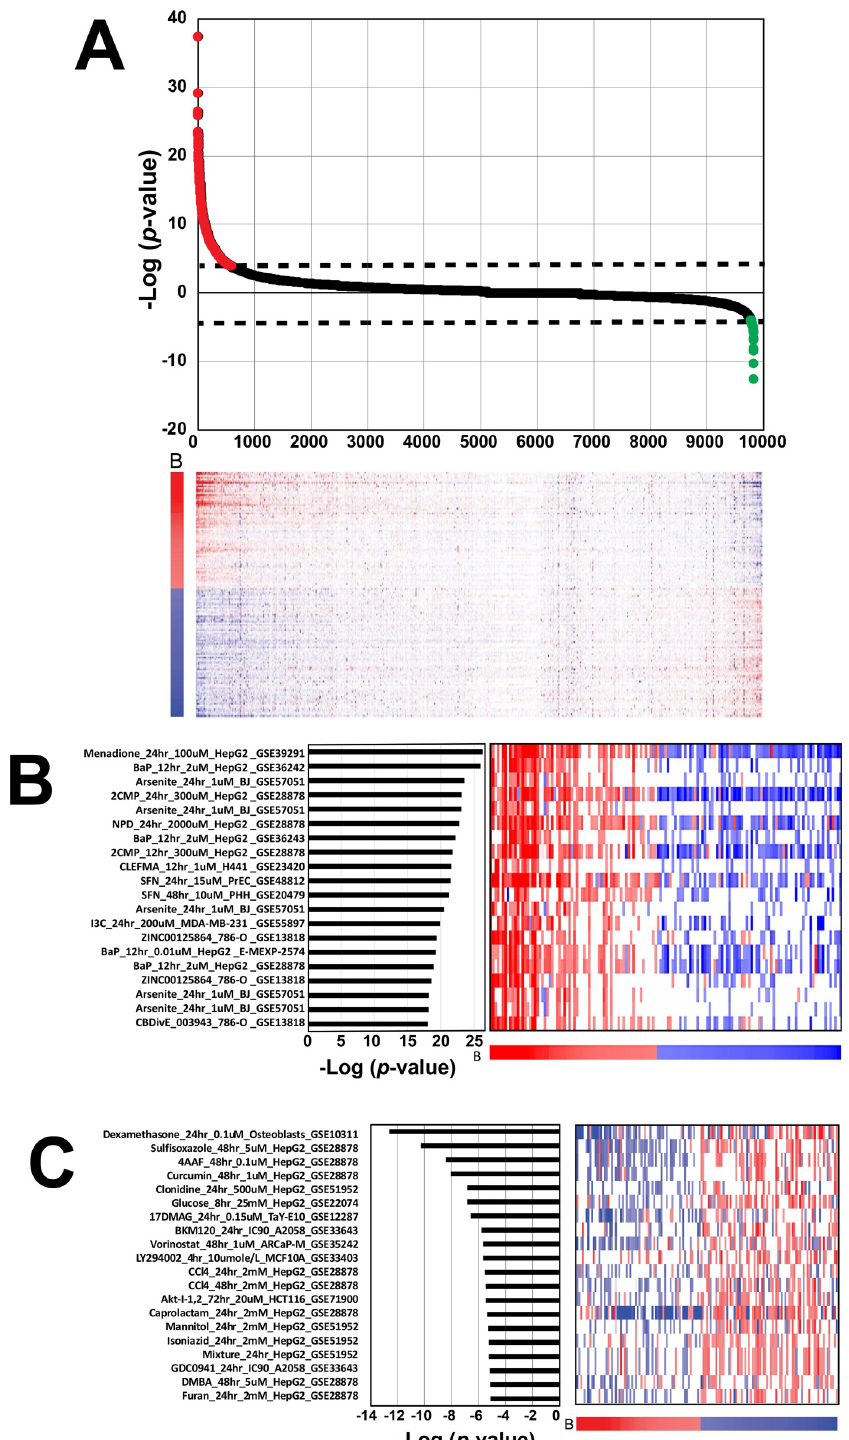
Fig 4. NRF2 activity across biosets from chemically treated human cells. A. (Top) Biosets derived from microarray comparisons of human cells exposed to chemicals were rank ordered based on their correlation to the biomarker using the -Log(p-value) of the Running Fisher test. Biosets with positive correlation (red) to the biomarker are on the left and biosets with negative correlation (green) to the biomarker are on the right. The dashed lines denote the cutoff p- value = 10 − 4 . (Bottom) The heat map shows the expression of genes in the biomarker across the biosets. B, biomarker